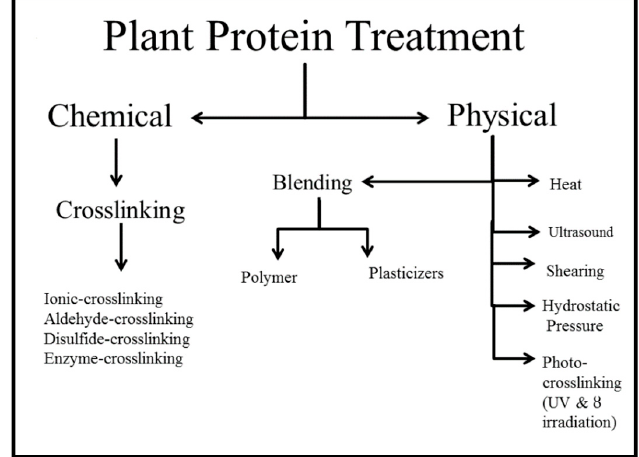
Figure 4. A schematic of different plant protein treatments.